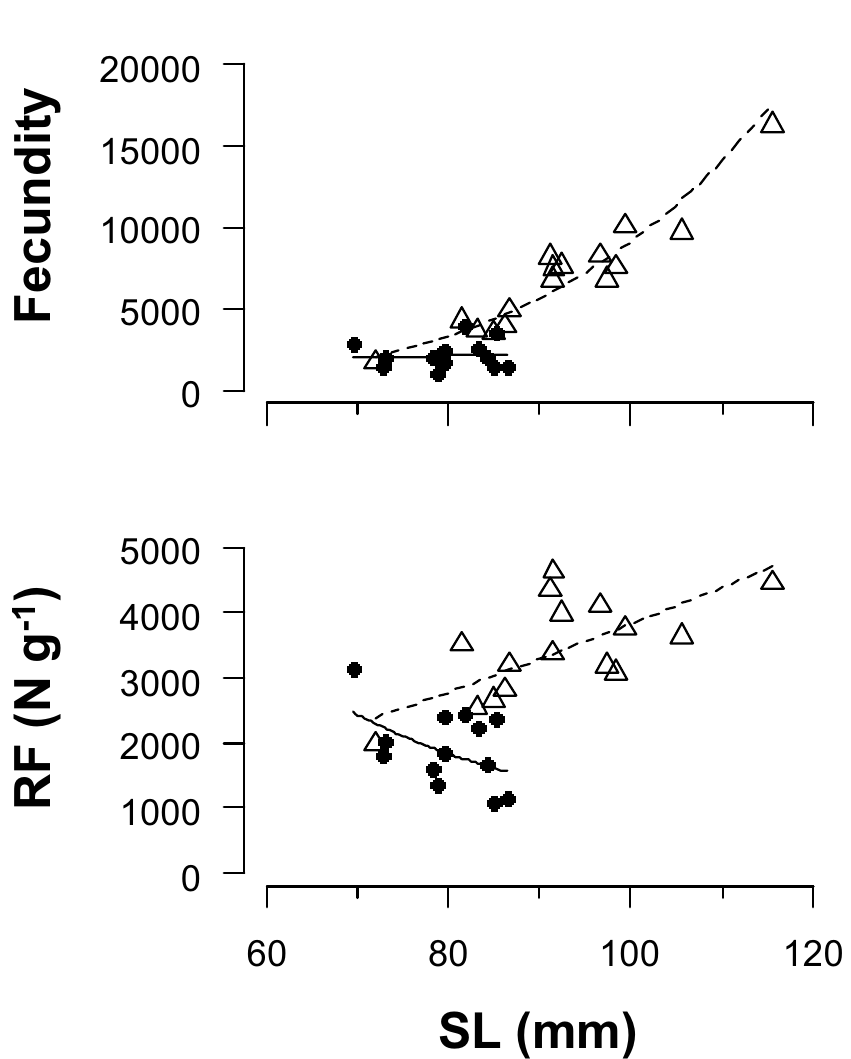
Fig 5. Relationship between standard length (SL) and fecundity or relative fecundity (RF: Number of oocytes per unit body weight) in western sand lance ( Ammodytes japonicus ) in Experiment II. Individuals collected on December 26 and January 11 were used. Open triangles and solid circles indicate high and low ration groups, respectively. Dashed and solid lines represent the linear models fitted to the data of high and low ration groups,